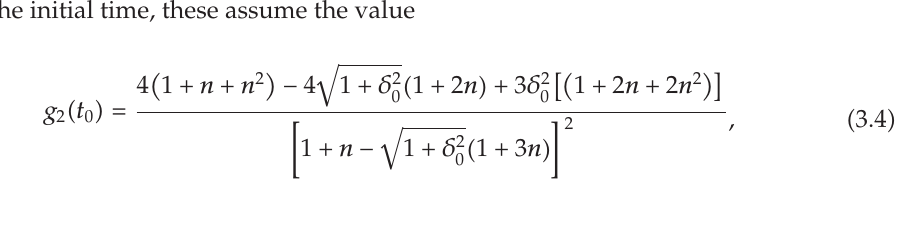
Figure 1: Wigner functions: (cid:4) a (cid:5) | 0 (cid:4) for (cid:4) ω, (cid:20) t (cid:4) ω, ω (cid:5)(cid:8)(cid:4) 0.1,0.005 (cid:5) ; (cid:4) d (cid:5) | 2 (cid:4) for (cid:4) ω, t 0